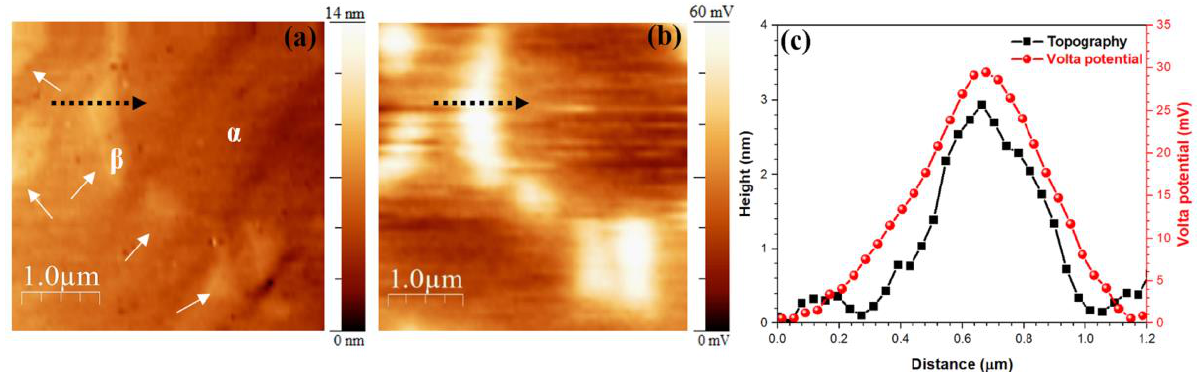
Figure 2. ( a ) AFM topography and ( b ) SKPFM Volta potential maps of polished Ti6Al4V alloy, ( c ) line profiles along the black dashed arrow of (a) and (b).